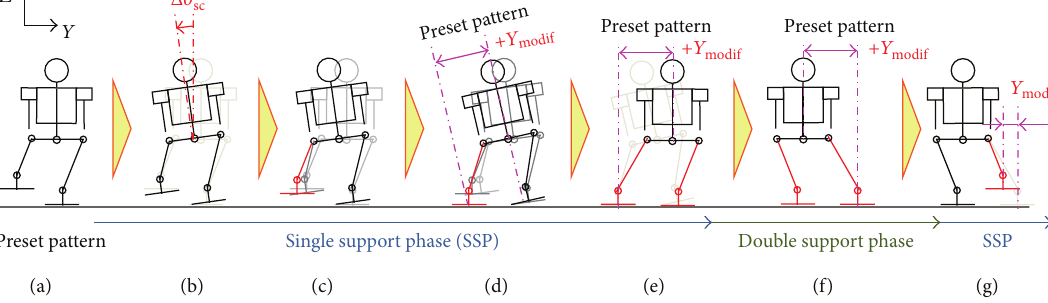
Figure 3: Outline of the foot placement modification control.